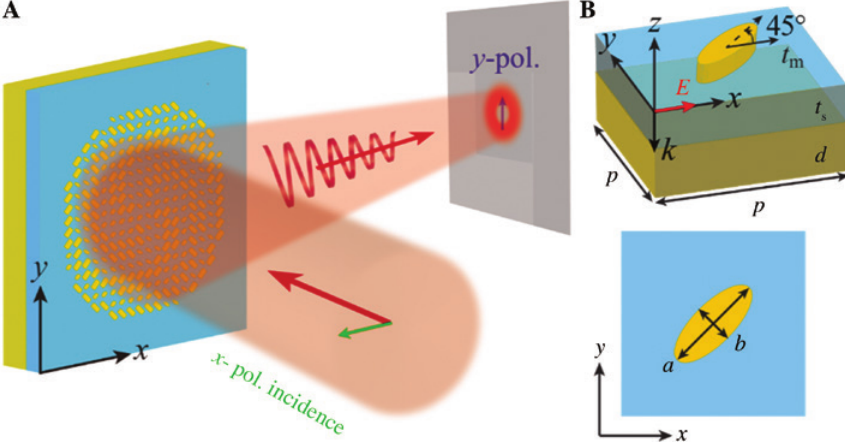
Figure 1: Schematic of the metasurface. (A) Artistic illustration of the metasurface for linear-polarization conversion and focused vortex-beam generation. (B) Schematic of the basic meta-atom that consists of an Au nanoantenna on top of a spacer and Au substrate with dimensions of p = 550 nm, d = 130 nm, t = 80 and t m